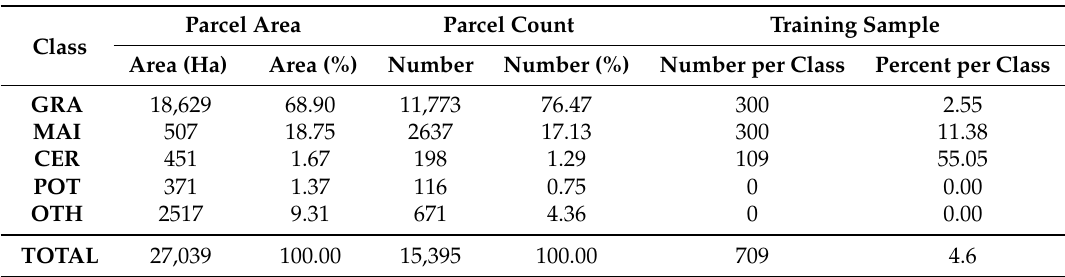
Table 4. Parcel area, distribution per class for the study area and sample used for classification training. GRA, Grassland; MAI, Maize; CER, Cereals; POT, Potatoes; OTH, Other.